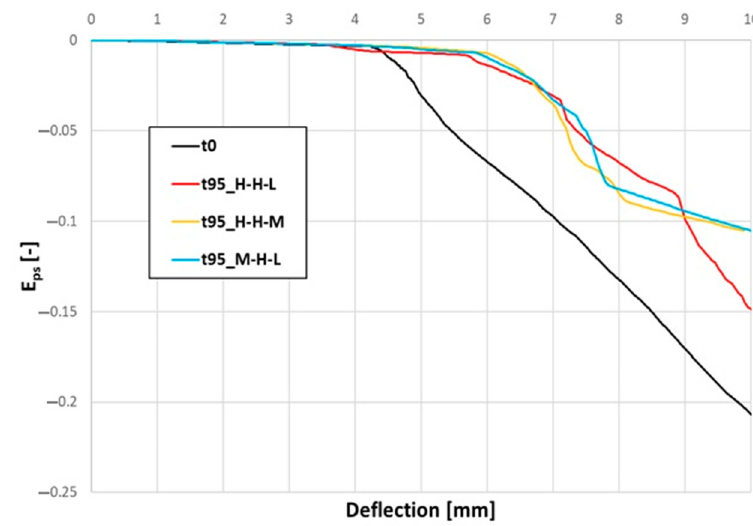
Figure 25. Minimum equivalent plastic strain-deflection curves.